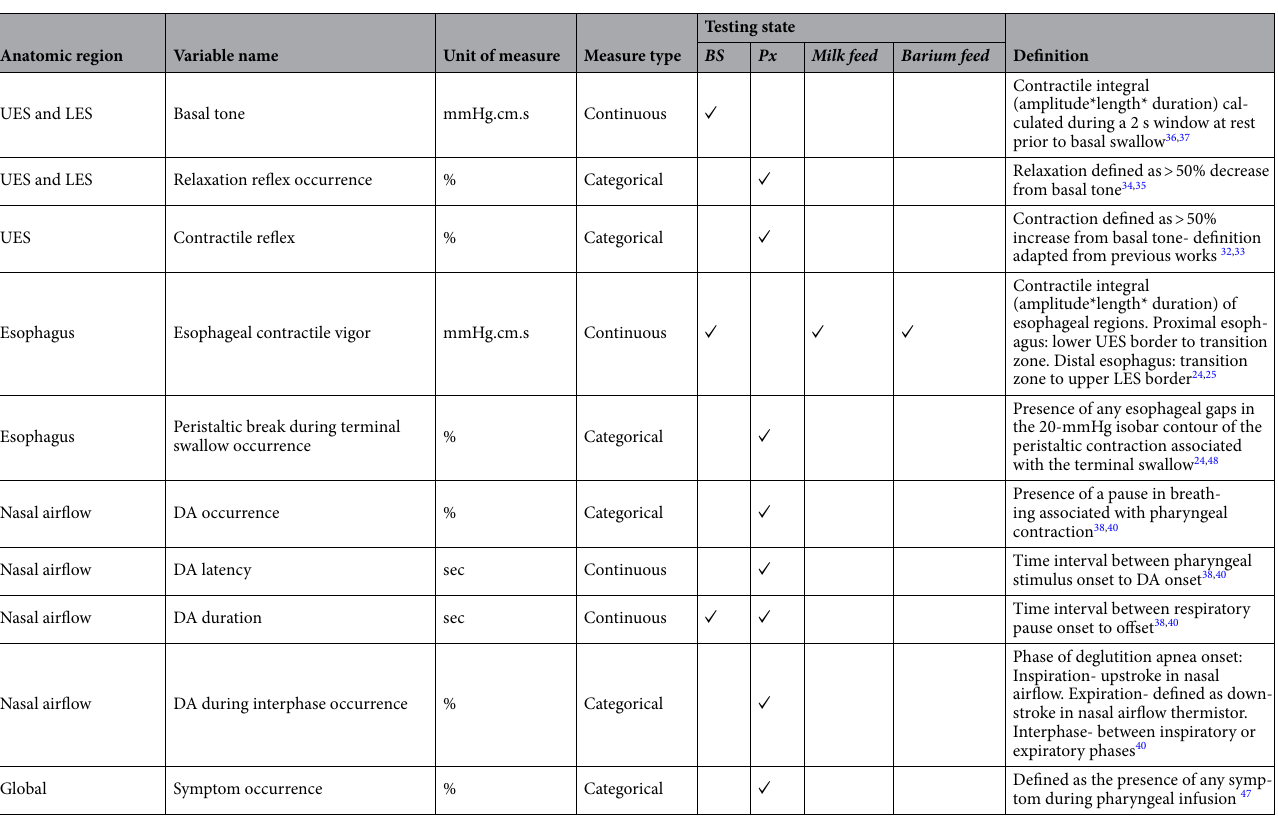
Table 1. Videofluoroscopy swallow study and high resolution motility metrics and analysis definitions. BS-Basal Swallow, Px-Pharyngeal Infusion, DA- deglutition apnea, Milk Feed- Oral Feeding with Milk, Barium Feed- Oral Feeding with Barium-Sulfate, ✓ : variable was analyzed for marked